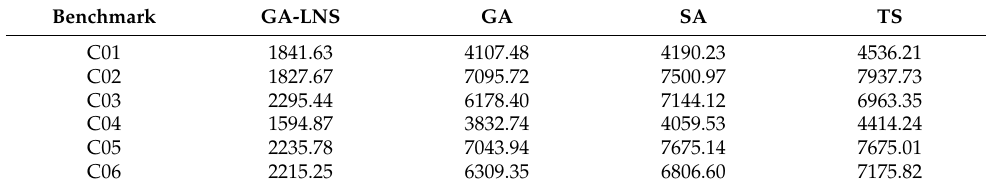
Table 3. A comparison of travel cost with the GA-LNS, GA, SA and TS algorithm.